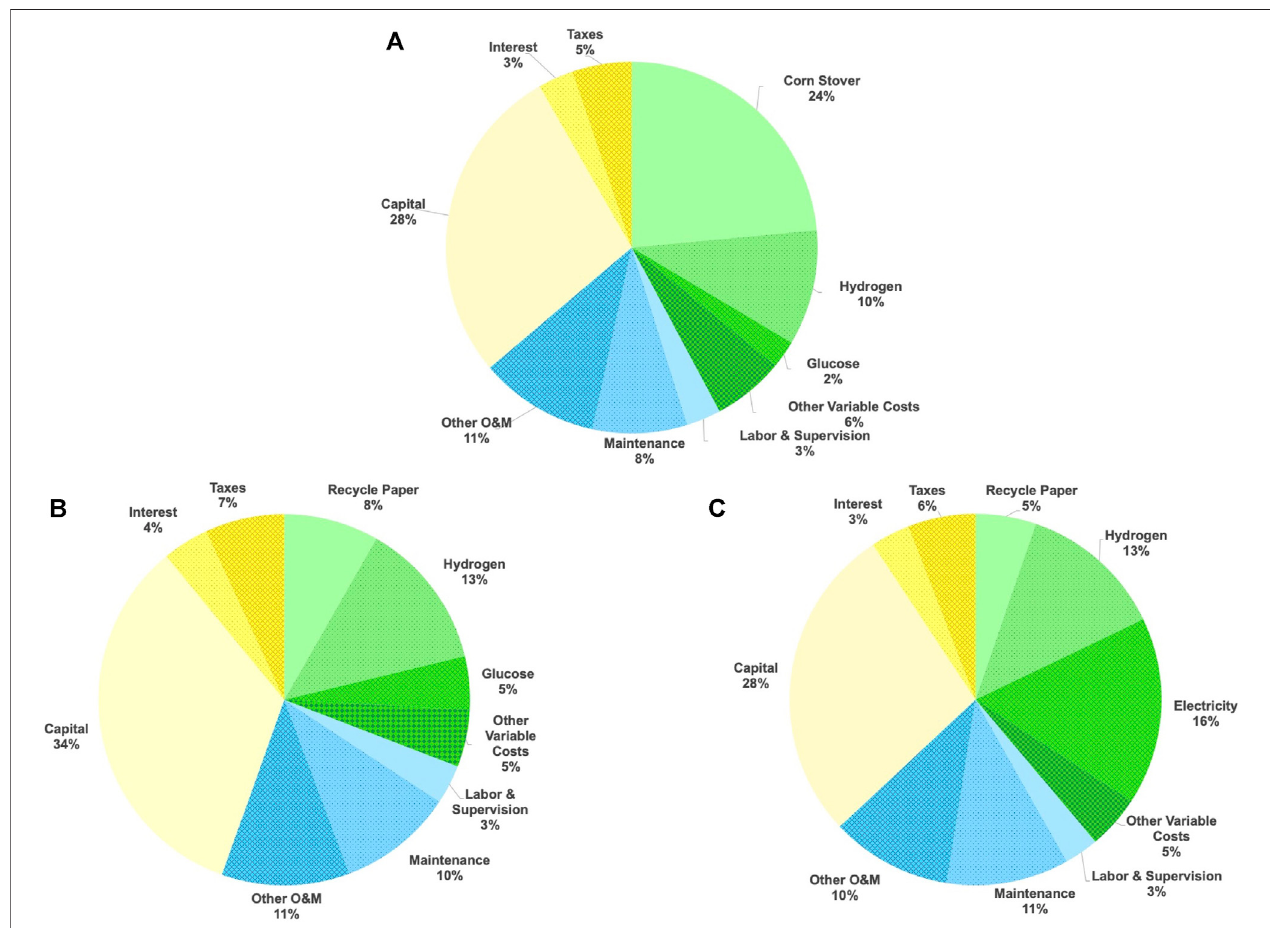
FIGURE5| Costbreakdown byexpensecategoryfor (A) CornStovertoJetFuelProcess, (B) PapertoJetFuelProcess withEnzymaticHydrolysis,and (C) Paper to Jet Fuel Process with Acid Hydrolysis.